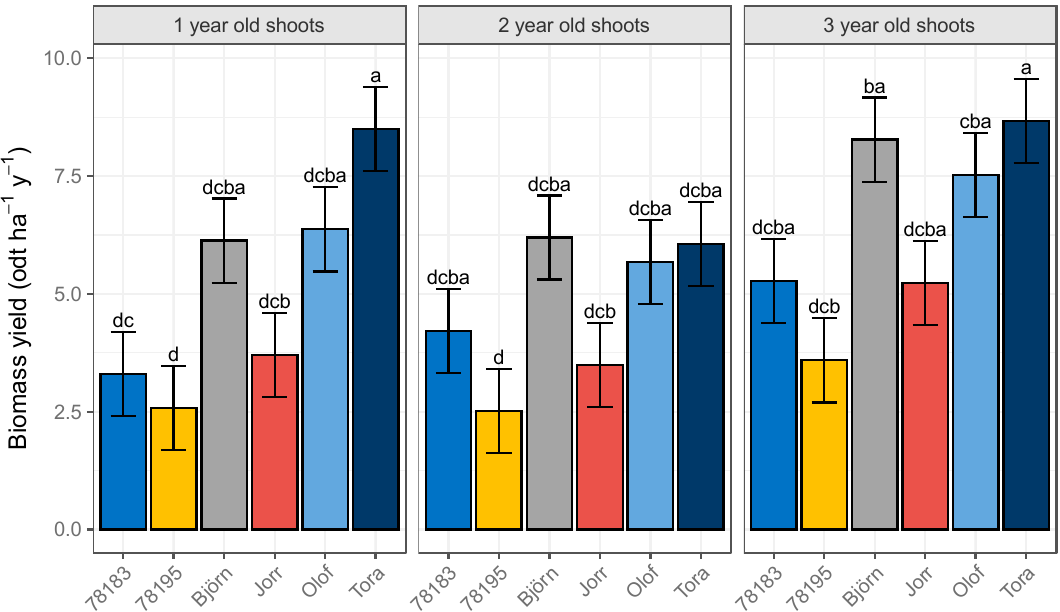
Figure 2. Least-squares means of the biomass productivity (odt ha − 1 y − 1 ) per clone and shoot age at harvest. Error bars indicate standard error. Shared letters indicate statistically non-significant differences between pairs across clones and shoot ages.